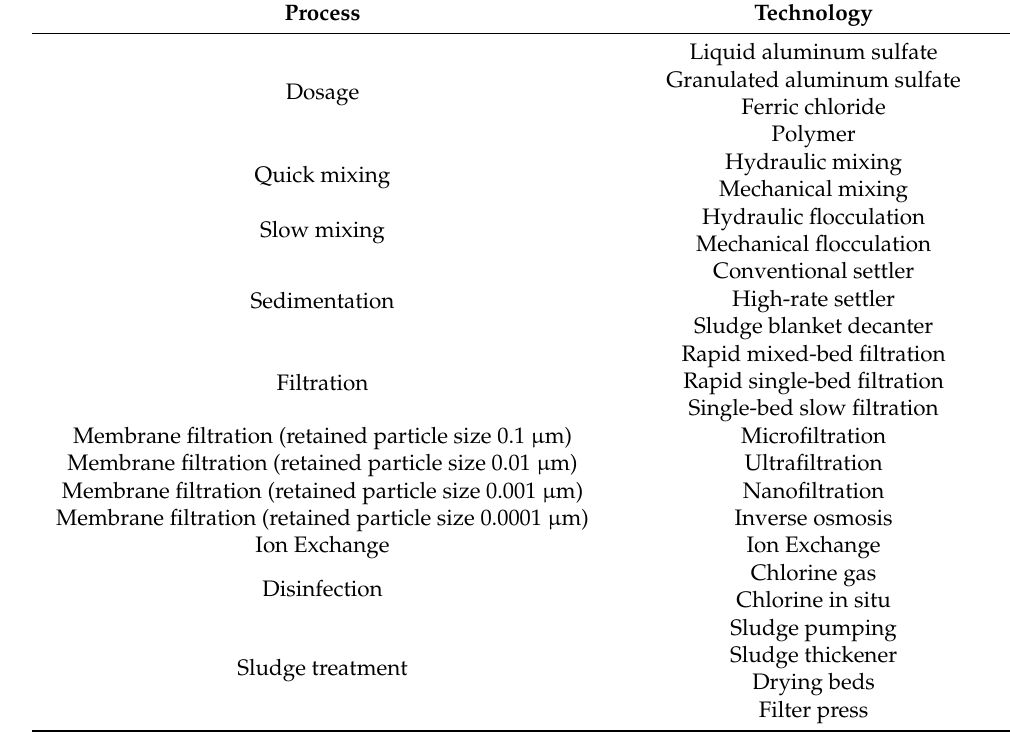
Table 5. Technologies available by default for selection in WaterProof in each process of the treatment